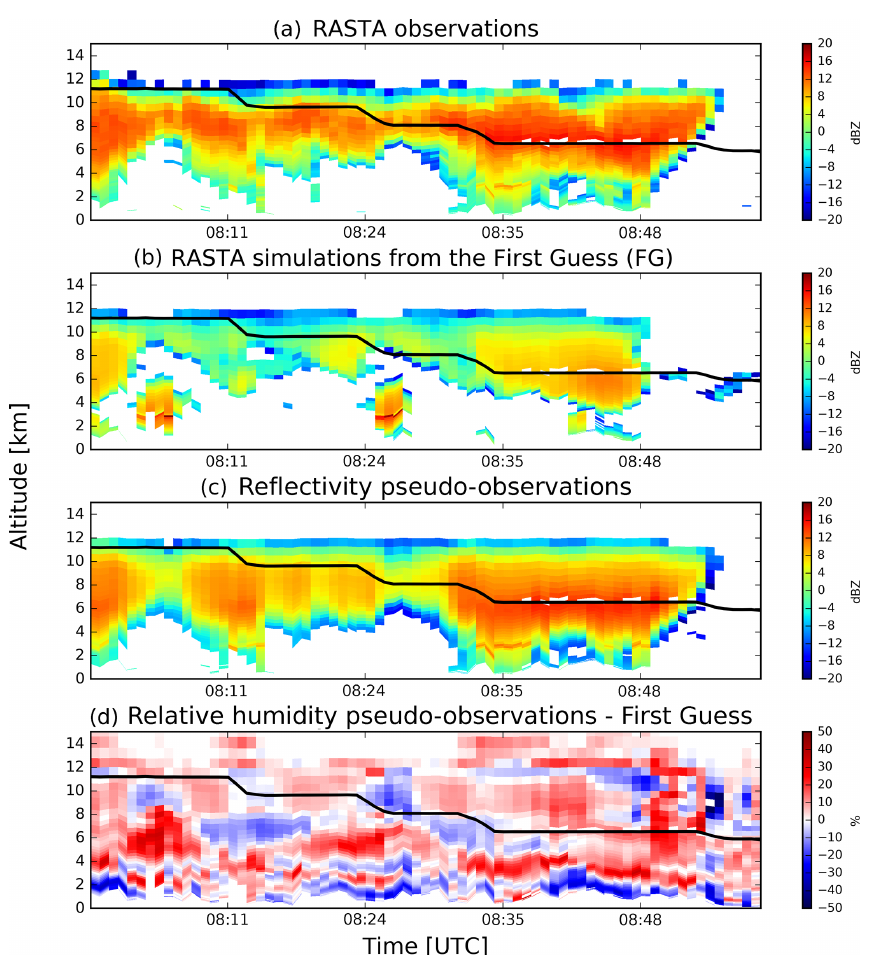
Figure 5. Time–height cross section of the reflectivity observed by RASTA (a) , simulated from the background (b) and pseudo- observations (c) . The differences between the RH pseudo-observations and the relative humidity from the background state are shown in (d) . Aircraft altitude is indicated by the black